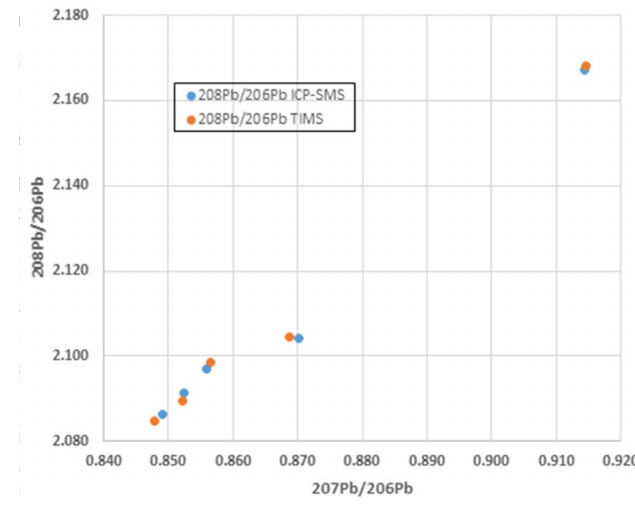
Figure 5. Excellent agreement in major isotopic ratios between thermal ionization (TIMS) and single detector magnetic-sector field ICP-MS (ICP-SMS) associated with rigorous sample preparation and analysis (data from [30]).